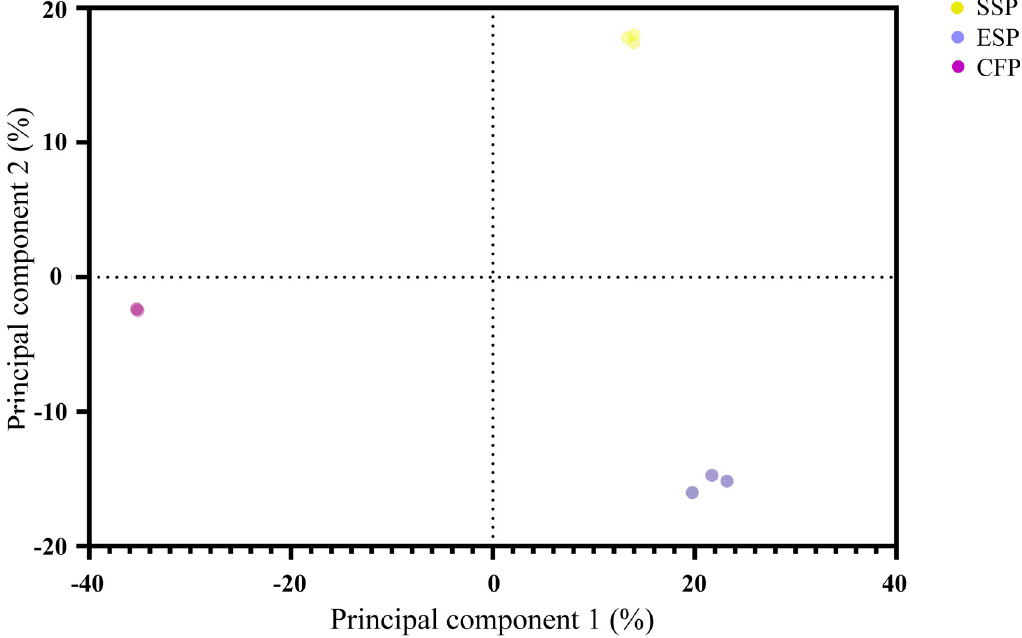
Fig 2. Principal component analysis. The PCA plot represents 2,137 parasite-related proteins with biological replicates that indicated distinct proteomics profile differences between soluble somatic proteins (SSP), excretory/secretory proteins (ESP), cyst fluid proteins (CFP) samples types represented with yellow, purple and pink dots,